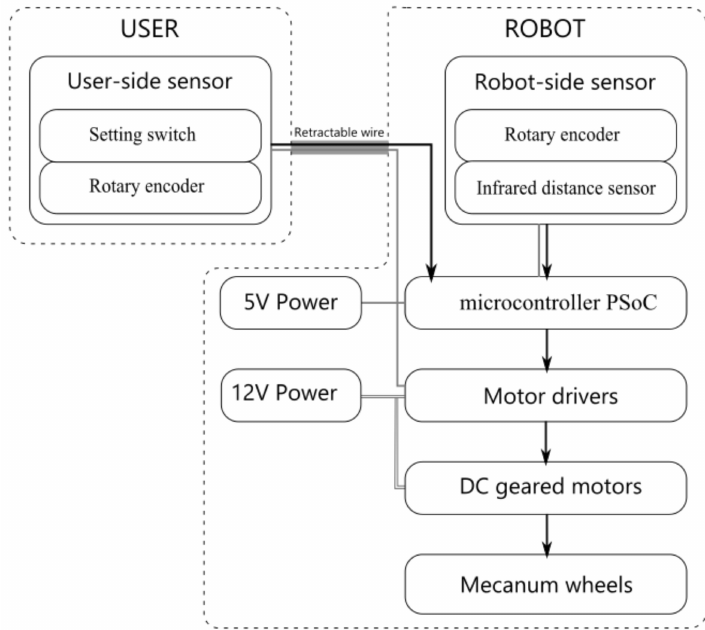
Figure 4. System structure block diagram.